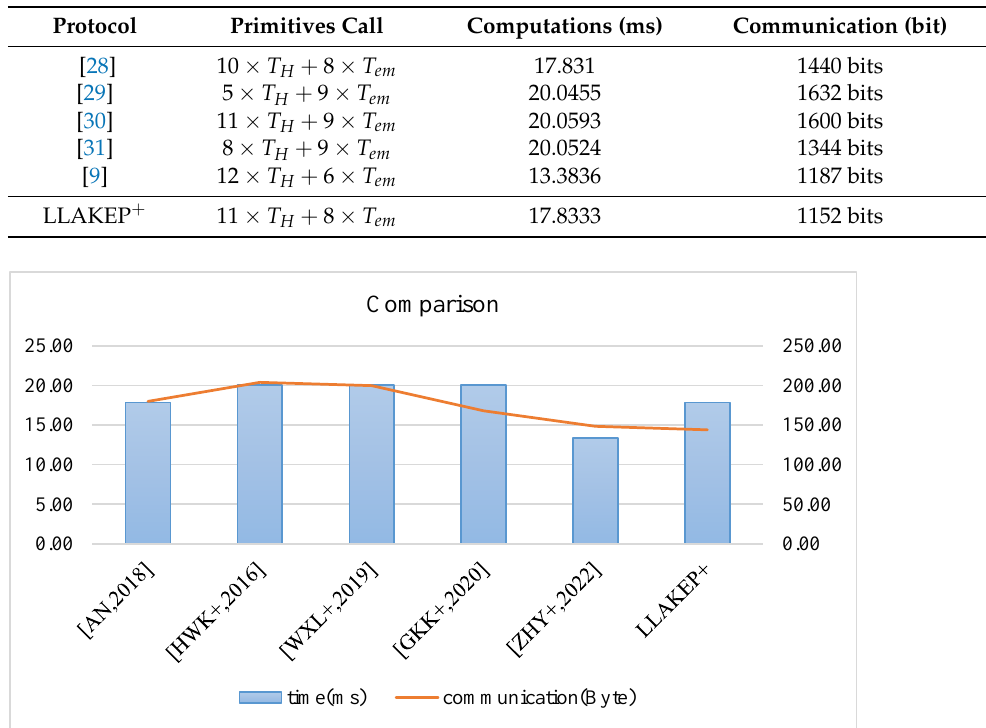
Table 2. Cost comparison of LLAKEP + and other related protocols.